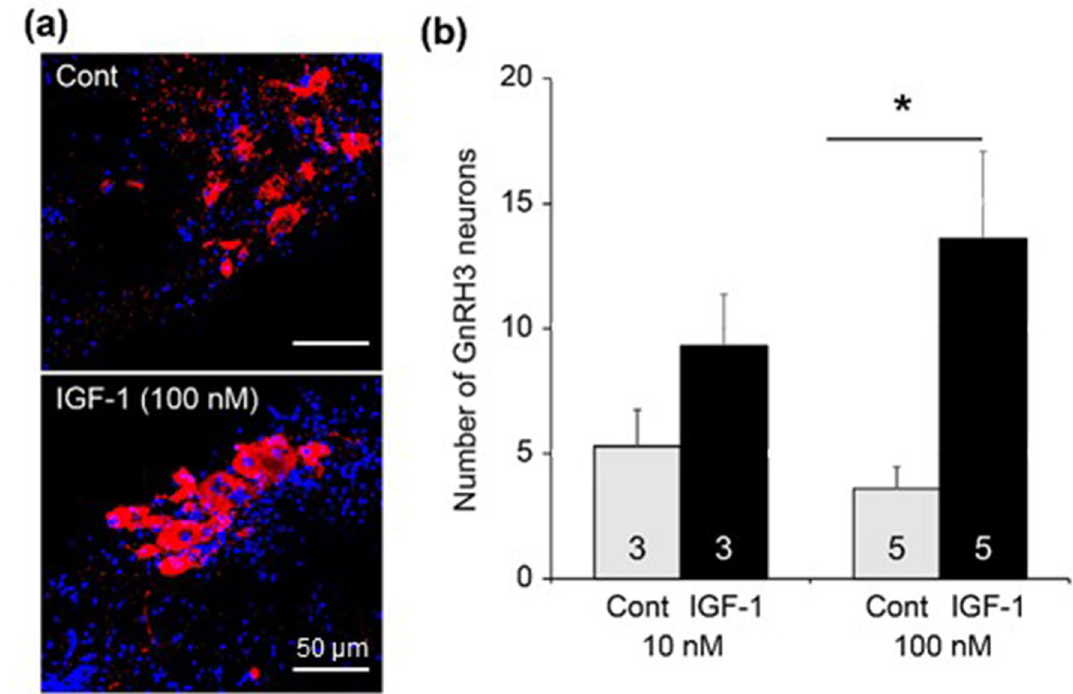
Figure 3. ( a ) Representative images of gonadotropin-releasing hormone 3 (GnRH3) neurons (red) in control (cont) and insulin-like growth factor 1 (IGF-1)-treated (100 nM) slices. Cell nuclei (blue) were stained with Hoechst 33342. ( b ) The numbers of GnRH3 neurons in control (Cont) and IGF-1 (10 nM and 100 nM)-treated slices (scale bar, 50 μm). An asterisk indicates a significant difference at p <0.05 (paired Student t -test). Numerals in bars indicate the numbers of animals used for preparing slices. Data are expressed as the mean ± standard error of the mean.